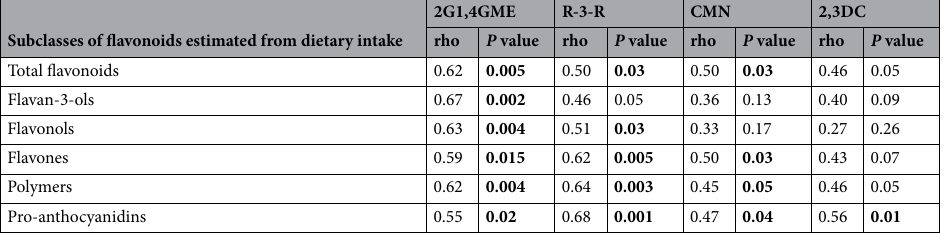
Table 2. Spearman’s correlation coefficient (rho) between dietary intake of flavonoids estimated from an FFQ with serum levels* of flavonoid metabolites (n = 17). Values in bold indicate a statistically significant P value (<0.05). *Based on specific metabolite abundance in serum; 2G1,4GM—2-Galloyl-1,4-galactarolactone methyl ester; R3R—Rhamnazin 3-rutinoside; CMN—Cyclocommunin; 2,3DC—22 ″ ,32 ″